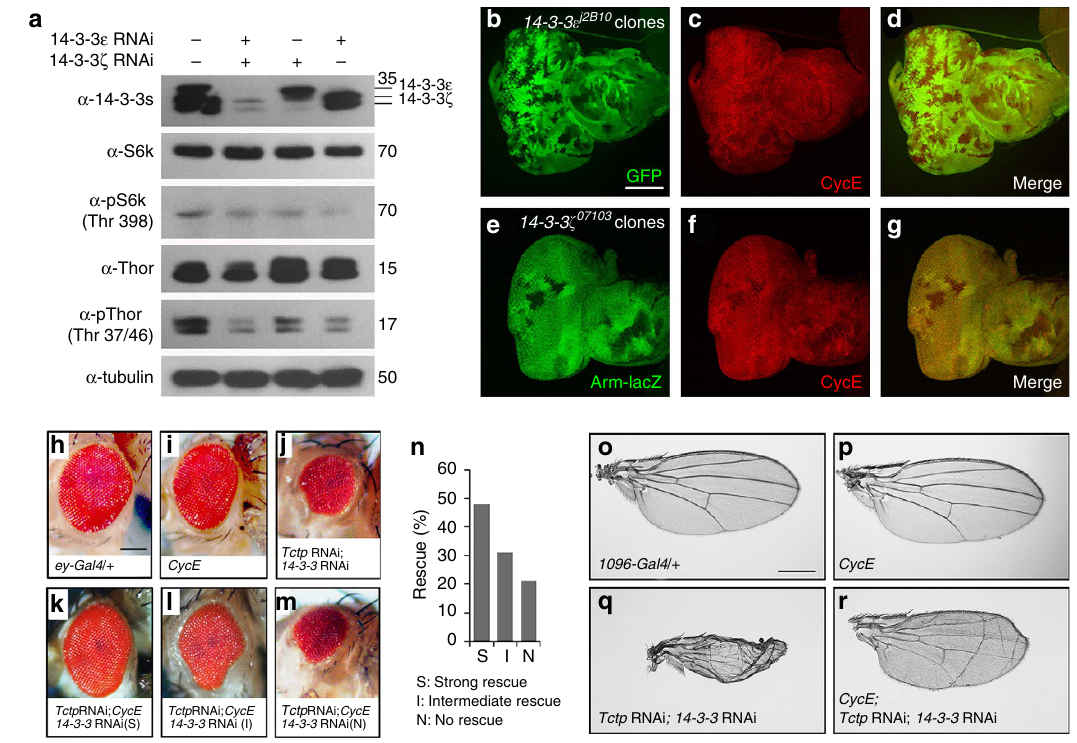
Figure 6 | Effects of 14-3-3 RNAi on Tor targets and the suppression by CycE. ( a ) Effects of 14-3-3 RNAi on S6k and Thor. Either one of 14-3-3 isoforms or both 14-3-3s were knocked down in S2 cells. Single or double knockdown of 14-3-3s reduced the level of pS6k (Thr 398) but does not affect the level